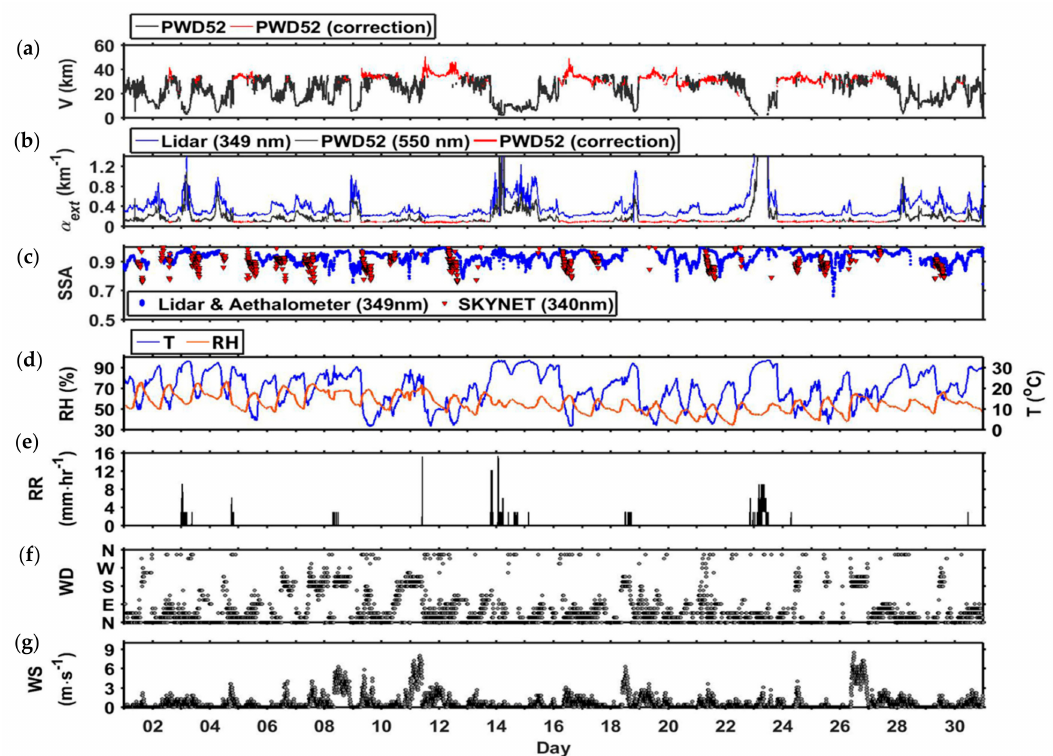
Figure 8. Temporal variations of aerosol and meteorological parameters observed for the whole campaign period in November 2017: ( a ) horizontal visibility (black) with extrapolated values (red) based on the regression line derived in Figure 6b, ( b ) aerosol extinction coe ffi cient, α ext , from both the near-horizontal lidar (349 nm) and visibility-meter (550 nm) data with the extrapolation for visibility ≥ 35 km, ( c ) single scattering albedo (SSA), from both lidar and aethalometer (349 nm), and sky radiometer of SKYNET (340 nm), ( d ) relative humidity (RH) and ambient temperature, ( e ) rain rate (RR), ( f ) wind direction (WD), and ( g ) wind speed